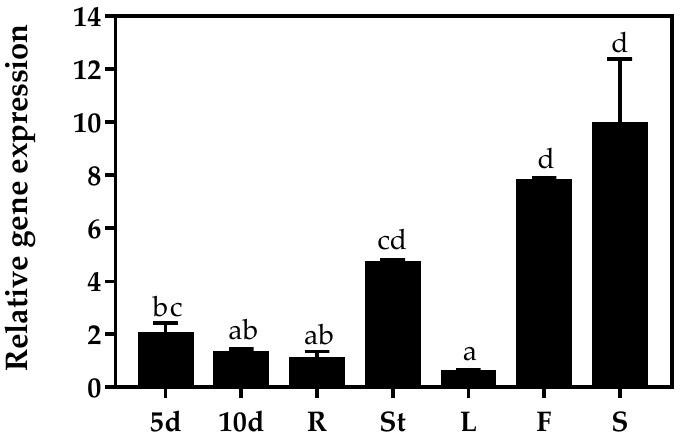
Figure 3. Gene expression profile of AtZAT4 in vegetative and reproductive tissues of Arabidopsis thaliana and in 5- and 10-day-old seedlings. 5d seedlings of 5-day-old, 10d seedlings of 10-day-old, R root, St stem, L leaf, F flower, S silique. Values represent mean ± SE ( n = 3). The constitutive expression of the gene AtF-box [32] and the 2 − ∆∆ Ct method described by Livak and Schmittgen (2001) [33] were used for normalization. The transcript levels obtained for R were taken to assign the value one. Data correspond to the mean ± SE. Significant differences ( p ≤ 0.05) are shown with different letters. For details, see the Materials and Methods section.